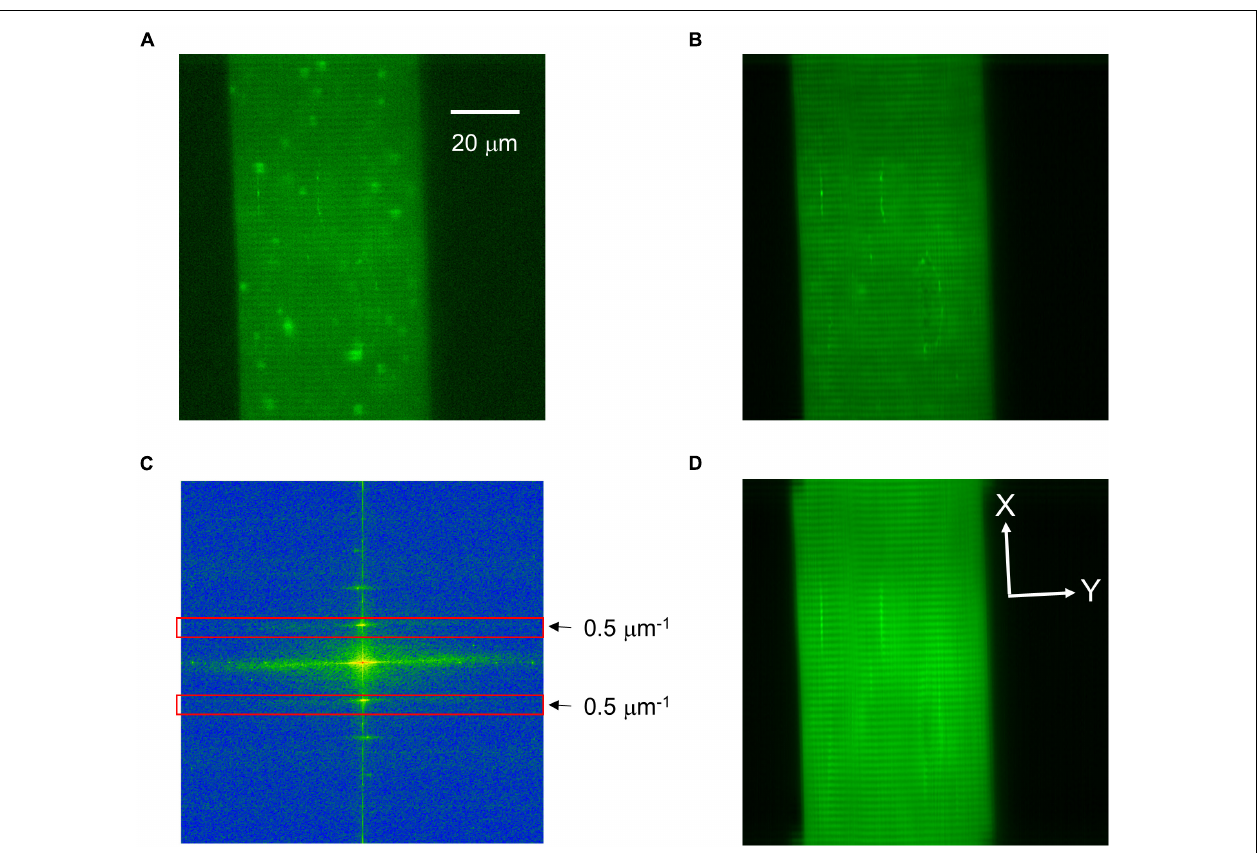
FIGURE 1 | Identification of the cell structure in a representative x-y image. (A) An original x-y image of an intact frog skeletal muscle fiber loaded with Fluo-4 displaying calcium release events. (B) The picture of the basic fluorescence values of each pixel showing good signal-to-noise ratio for static image elements, such as Z-lines. (C) Fast Fourier transform showing the frequency spectrum of the image in panel (B) . At 0.5 µ m − 1 (and at its inverse, red rectangles) the sharp band corresponding to one sarcomere is clearly visible. (D) The result of the inverse Fourier transformation, where the Z-lines are excellently traceable. White lines perpendicular (X) and parallel (Y) to the Z-lines determine the directions of FWHMs. Scale of panels (B,D) is identical to that in panel (A)